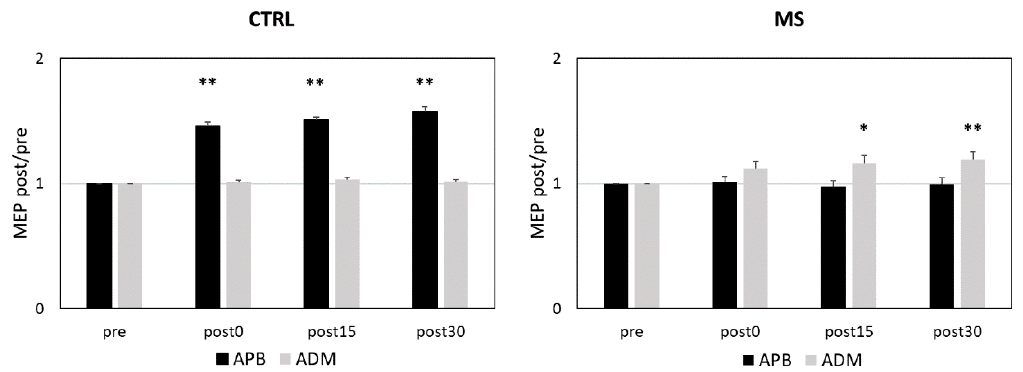
Figure 1. PAS Effects in RR-MS Patients and Controls. Figure 1 legend. In healthy subjects, PAS elicited the expected homosynaptic LTP-like effect in the APB muscle ( left panel ), whereas in MS patients, PAS elicited heterosynaptic LTP in the ADM muscle ( right panel ). * p ≤ 0.05; ** p ≤ 0.01. The p values refer to the comparisons between pre and post 0, post 15, and post 30 in each muscle. All p values were adjusted by Benjamini–Hochberg correction. Abbreviations: APB (abductor pollicis brevis); ADM (abductor digiti minimi); MEP (motor-evoked potential); PAS (paired associative stimulation); RR-MS (relapsing-remitting multiple sclerosis).